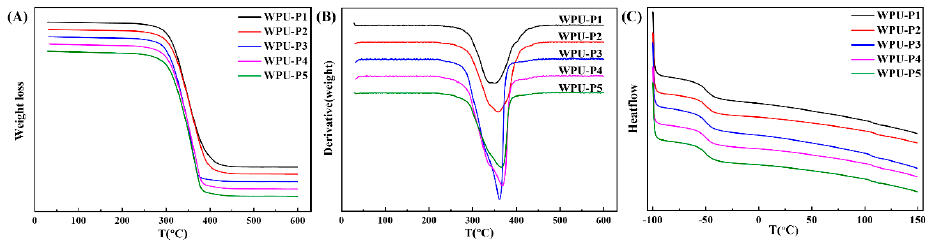
Figure 13. ( A ) TG, ( B ) DTG and ( C ) DSC curves of WPU-P films with di ff erent PCLD contents. Figure 13. ( a ) TG, ( b ) DTG and ( c ) DSC curves of WPU-P films with different PCLD contents.